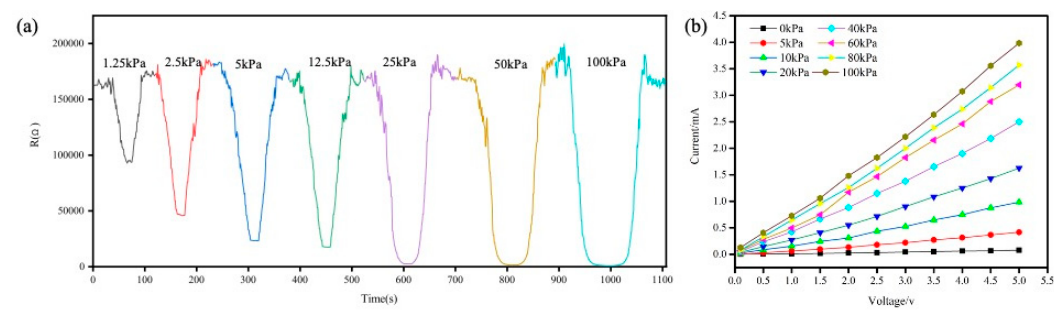
Figure 5. ( a ) Relative electrical resistance changes under different pressures ( b ) current-voltage characteristics.